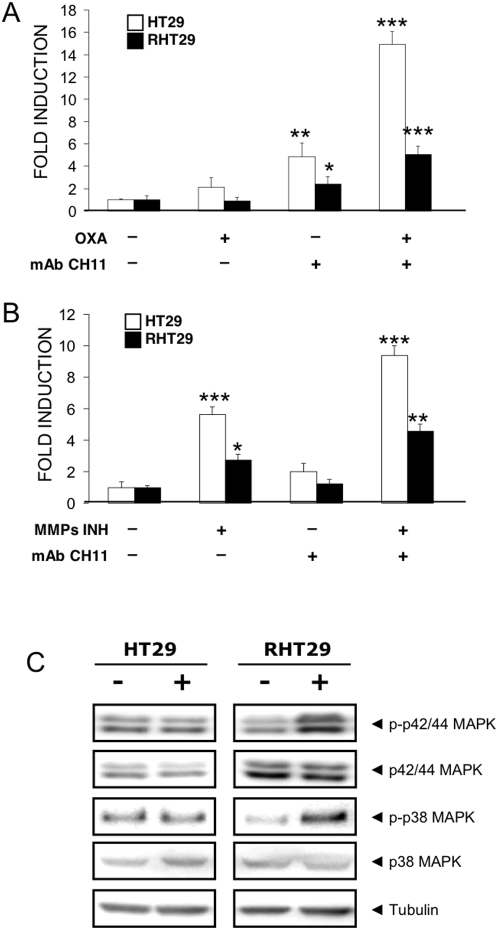
Analysis of the different pathways activated by Fas in HT29 and RHT29 cells.To determine the ability of Fas to induce cell death, cells were treated or not with A) oxaliplatin and B) MMP inhibitor for 24 hours, and then apoptosis was induced by the addition of the agonistic antibody CH11 at a final concentration of 150 ng/ml. Apoptosis induction by Fas activation was determined by annexin V/IP staining as described in Materials and Methods. Results are represented as arbitrary units assuming that control value is 1 and are mean±SEM for 3 samples per group. C) Activation of MAPK pathways in cells treated or not with 150 ng/ml of CH11 for 24 hours was detected by Western blot analysis. Tubulin expression was used as an endogenous control. Values that are significantly different between control and treated group by ANOVA analysis are indicated by *p<0.05,**p<0.001, ***p<0.0001. OXA: oxaliplatin.